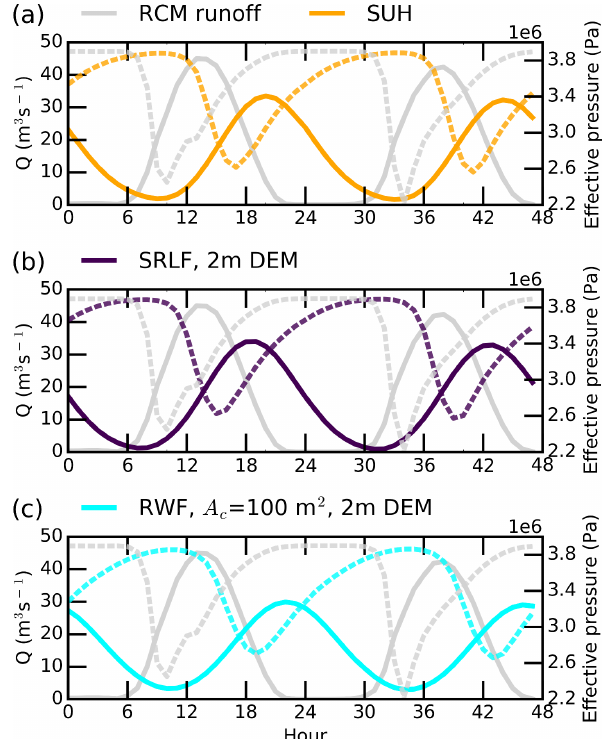
Figure 5. The average 2d cycle of moulin discharge ( Q ) for IDC1 during July 2015 derived from Figs. 2 and 3. The daily minimum in- put in supraglacial moulin discharge (solid lines) corresponds gen- erally to maximum effective pressure (dashed lines) and is followed within 8–9h by the daily minimum effective pressure (maximum subglacial water pressure). This suggests that the system shuts down due to creep with low meltwater input and becomes highly pressur- ized as meltwater input increases again. As the new water inputs are accommodated, efficient pathways reform, and effective pres- sure increases (subglacial water pressure